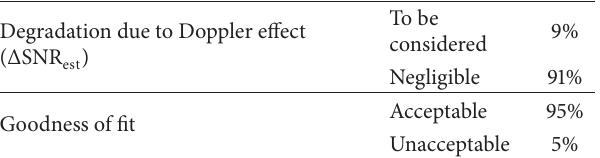
Figure 13: Example E: estimated PSD and corresponding exponen- tial fitting ( 𝑎 = 21.36 , 𝑏 = 2.94 ⋅ 10 −2 , 𝑐 = 41.87 , 𝑑 = 24.45 , 𝑒 = 6.81 ⋅ 10 −2 , 𝑔 = 39.45 , 󳵻𝑓 = 256.45 , and 𝛾 = 0.10 ). Table 3: Percentage of the total number of psds according to their degree of degradation due to Doppler effect and goodness of the exponential